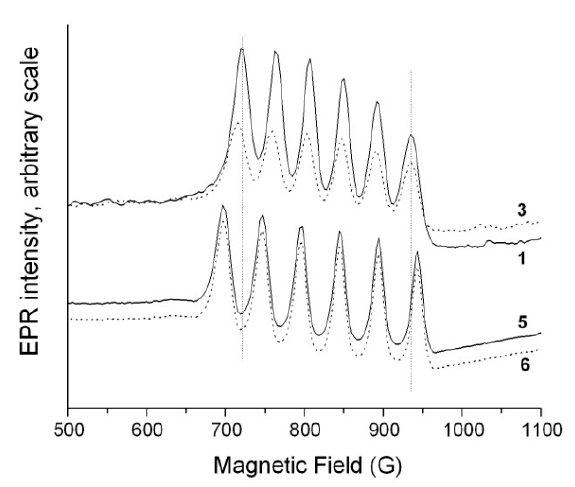
Figure 2. Parallel-mode electron paramagnetic resonance (EPR) spectra of 1 , 3 , 5 and 6 in frozen Toluene: dimethylformamide: EtOH (2:1:drop) solutions. EPR conditions: microwave frequency, 9.37 GHz; temperature, 6 K; microwave power, 2 mW.